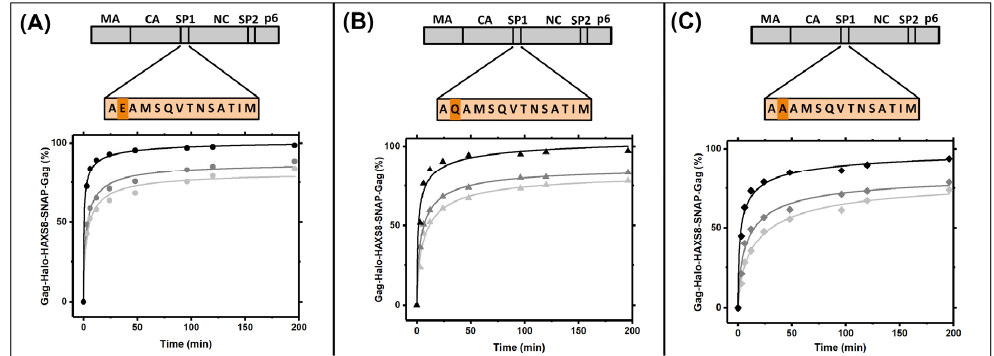
Figure 4. Quantification of Gag diffusion in SP1 mutants. The mathematical model developed in Figure 3 is applied to the raw data from ( A ) WT, which result in a pseudo diffusion coefficient of 10 nm 2 /s ( B ) E2Q which has 5 nm 2 /s and ( C ) E2A mutant which has a pseudo diffusion coefficient of 2 nm 2